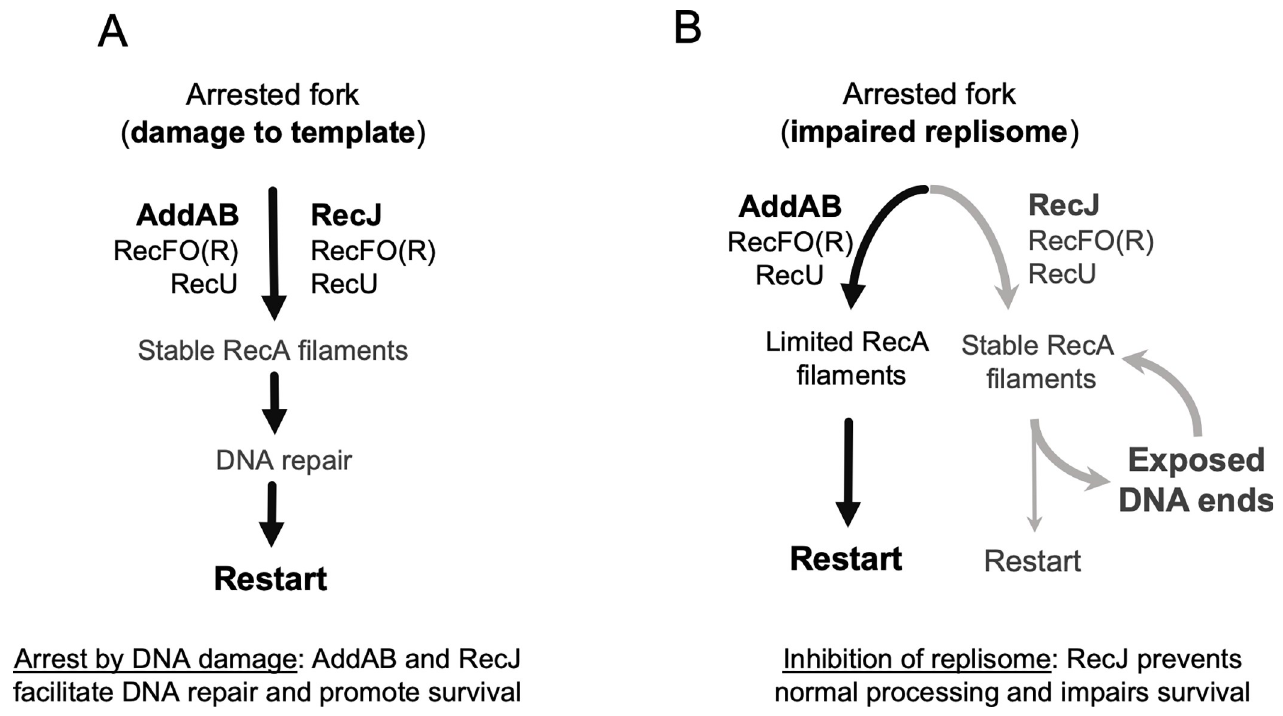
Fig 6. The role of end-resection pathways AddAB and RecJ on survival outcomes after replication arrest. A. When replication arrest is caused by lesions on the DNA template or other genotoxic stresses requiring RecA activity, both end-resection pathways work together, generating stable RecA filaments that delay restart and support DNA repair. B. If replication arrest is caused by the inhibition of replisome components or other stresses that do not require RecA, AddAB favors a pathway (black arrows) with limited RecA filaments that promotes survival. In this situation, RecJ and the RecA loader RecO and regulator RecF impair survival by promoting a pathway (gray arrows) with high RecA activity. This could prevent proper processing of the fork, exposing DNA ends and creating a futile circle.